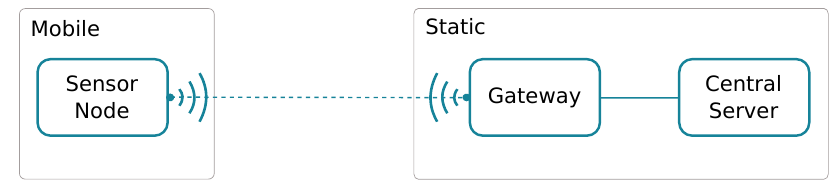
Figure 6. Wireless Sensor Network structure.